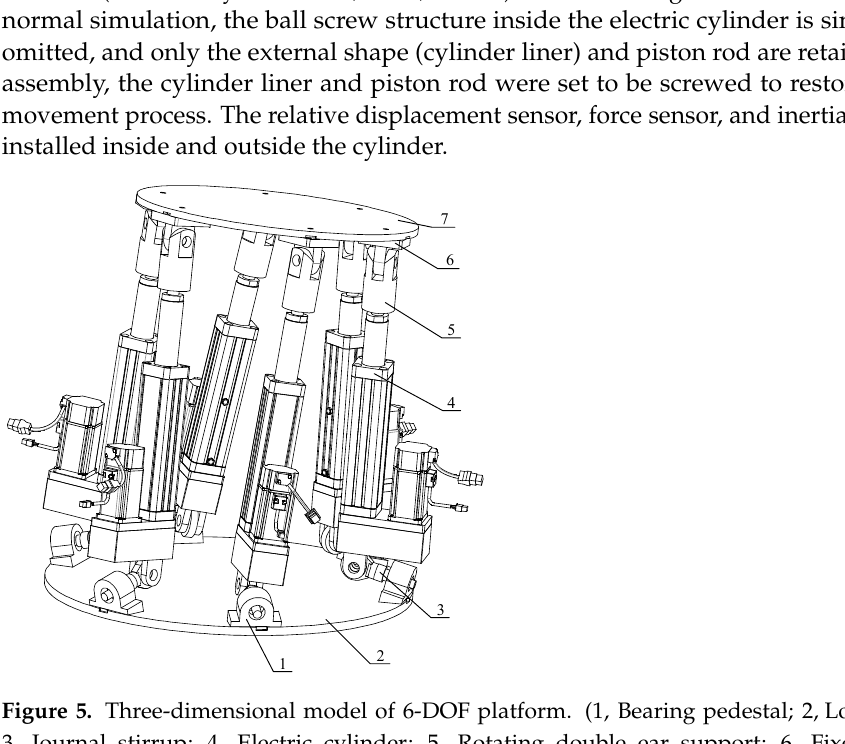
Figure 4. Explanation of the spatial position vector relationship .